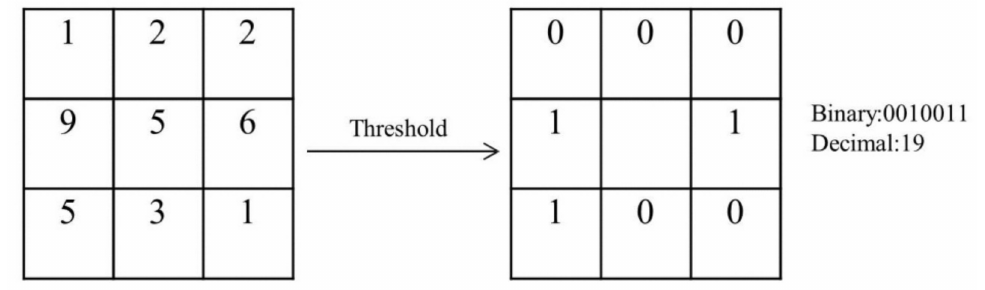
Figure 4. LBP operator